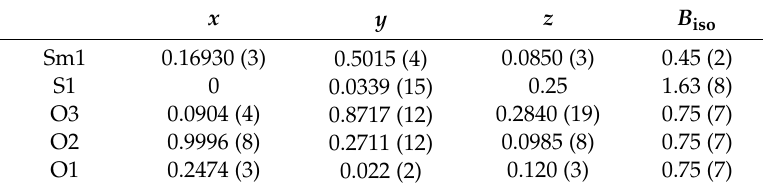
Table 2. Fractional atomic coordinates and isotropic displacement parameters (Å 2 ) of Sm 2 O 2 SO 4 .